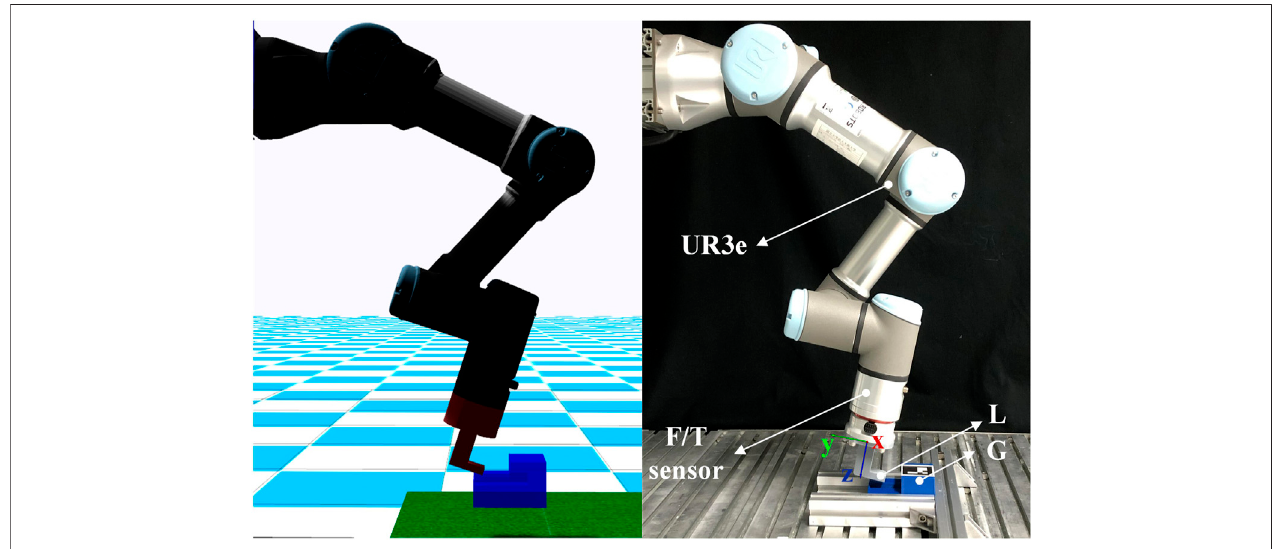
FIGURE 6 | Learning curves of the training sessions on A (2) task with frameworks using different trajectory learning methods: Adaptive DMPs (ADMP), demonstrated trajectory (DEMO), and RL without trajectory learning (w/o). The red dashed line represents the near-optimal reward.